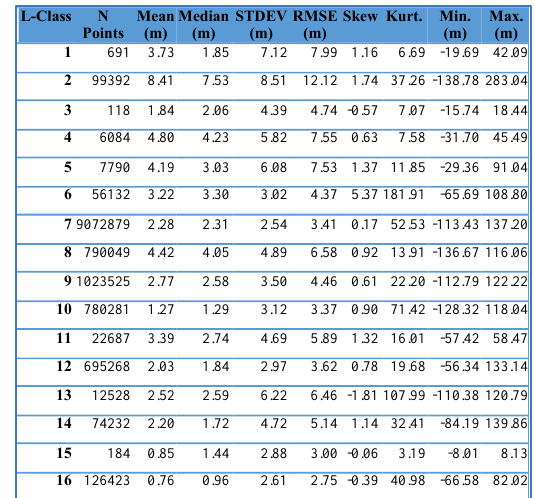
Figure 2. Differences between SRTM 90 m and ATL08 h_te_interp (in m) with respect to MODIS 0.5 km Land cover. Classification includes: 0-Water Bodies; 1-Evergreen needleleaf forest, 2-Evergreen broadleaf forest, 3-Deciduous needleleaf forest, 4-Deciduous broadleaf forest, 5-Mixed forest, 6-Closed shrublands, 7-Open shrubland, 8-Woody savannas, 9-Savannas, 10-Grasslands, 11-Permanent wetlands, 12-Croplands, 13-Urban and built-up, 14-Cropland mosaics, 15-Snow/Ice, 16-Barren or sparsely vegetated.